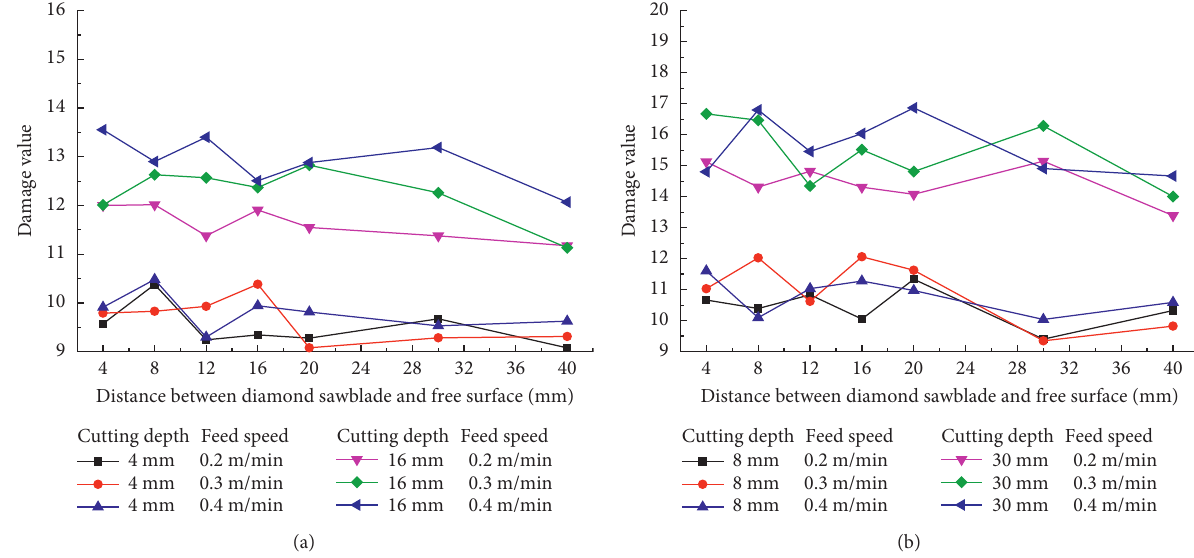
Figure 13: Variation curve of the rock damage value and distance between the sawblade and rock free